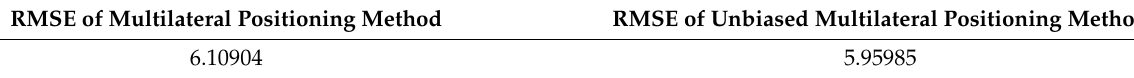
Table 1. Location error data under two